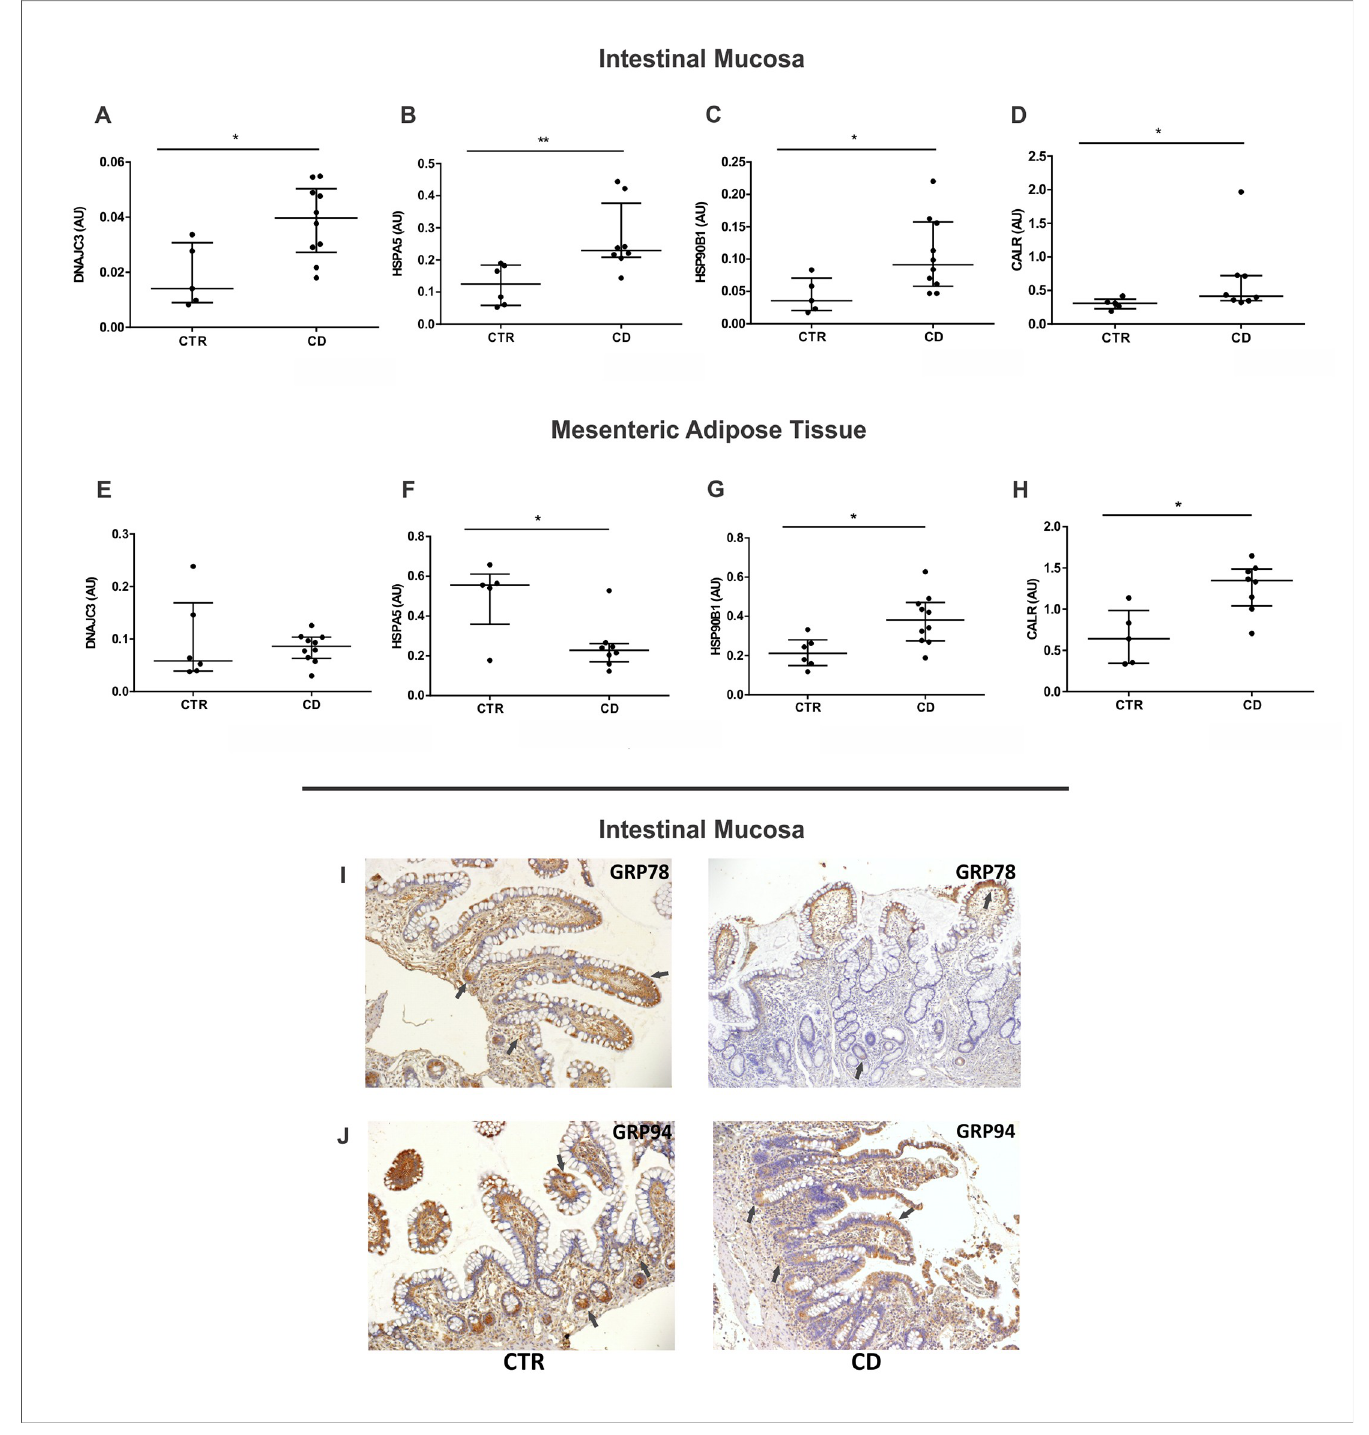
Fig 5. Chaperones and co-chaperone expression in the intestinal mucosa and in the mesenteric adipose tissue (MAT) of Crohn’s disease patients. mRNA levels (qRT-PCR) of DNAJC3 (A), HSPA5 (B), HSP90B1 (C) and CALR (D) genes were investigated in the intestinal mucosa of CD patients (CD group) compared to control group (CTR group). mRNA levels of DNAJC3 (E), HSPA5 (F), HSP90B1 (G) and CALR (H) genes were also investigated in the MAT of CD and CTR group. � p < 0.05 and �� p < 0.01 are considered statistically significant versus control group. Immunohistochemical analysis of GRP78 (I) and GRP94 (J) were performed on paraffin- embedded slides from intestinal mucosa of CD and CTR group. The arrows show labeled epithelial cells by immunohistochemistry. Original magnification 100X. AU: arbitrary unit.